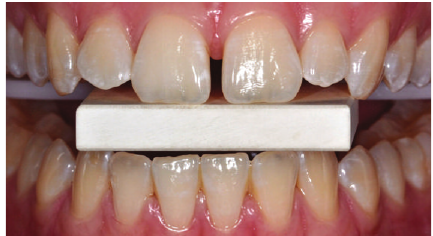
Figure 1: Initial picture taken with calibration block.